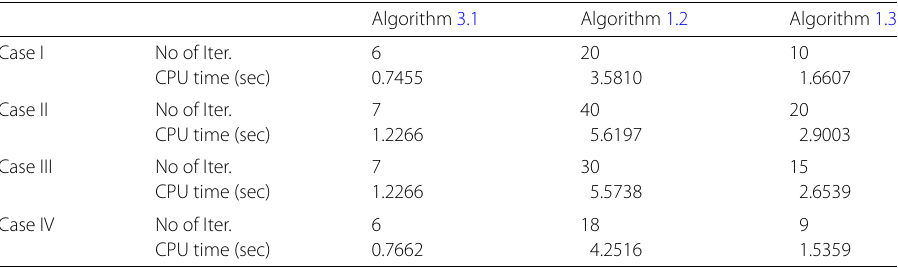
Table 3 Computational result for Example